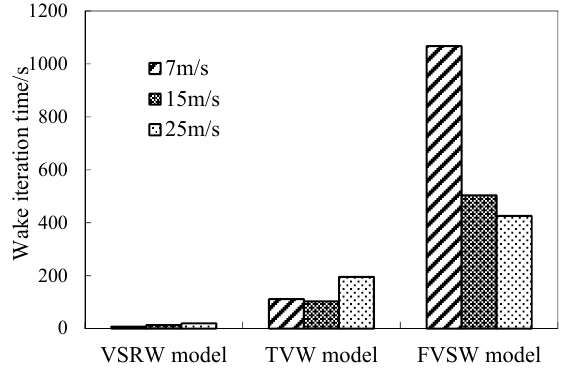
Figure 9. Wake iteration time of the VSRW model, TVW model, and FVSW model at 7 m/s, 15 m/s, and 25 m/s.